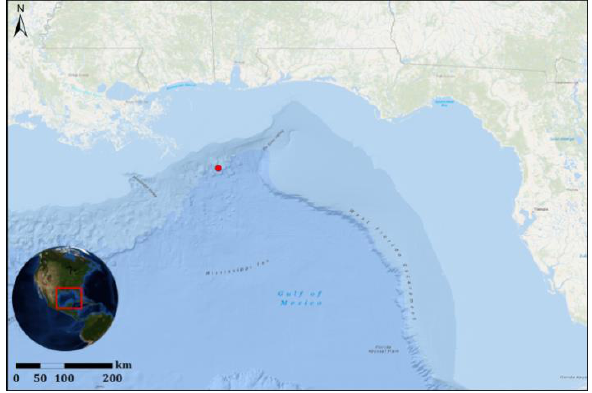
Figure 1. Gulf of Mexico research area. The red indicates the location of the source of the oil spill.